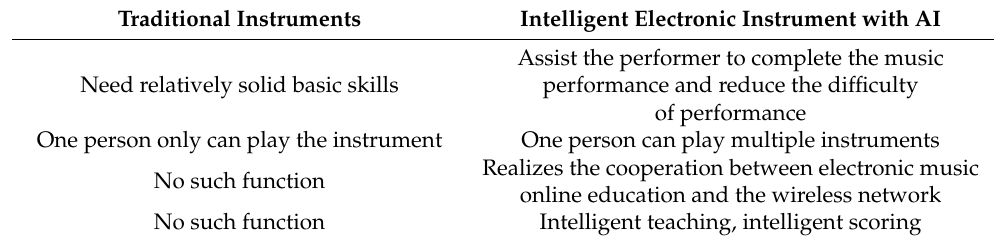
Table 1. Comparison between traditional instruments and intelligent electronic instruments with